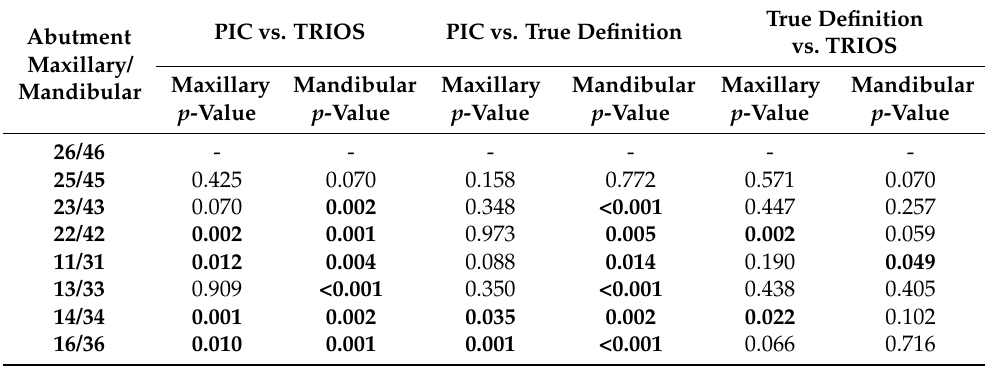
Table 8. p values of the comparisons of each of seven relative angulations for both arches with three different IOSs combination. Significant p -values highlighted with bold